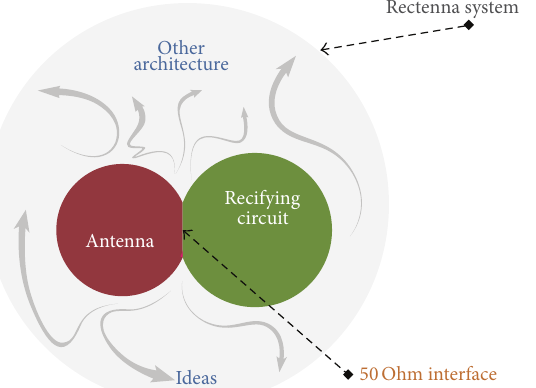
Figure 2: Schematic of the folded dipole